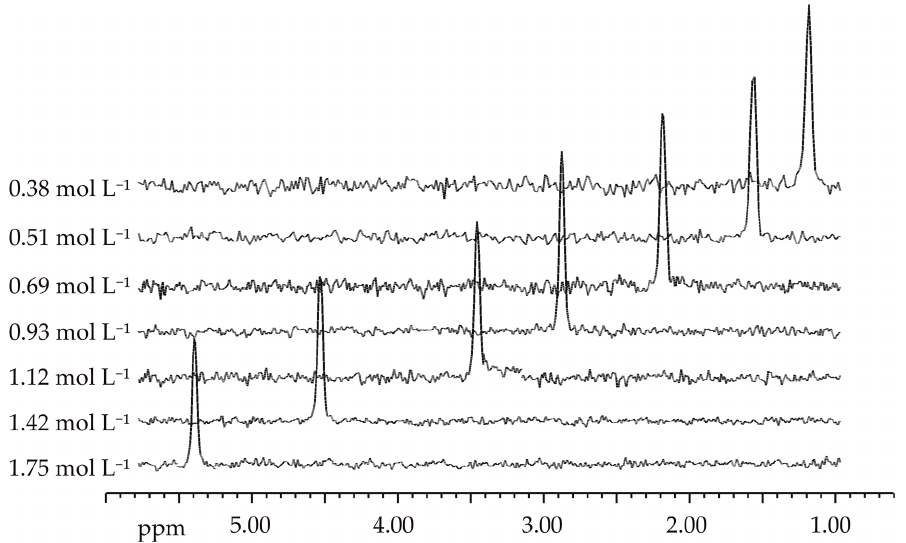
Figure 3. The series of 83 Kr NMR spectra measured at di ff erent krypton densities in the range Figure 3 0.38 ÷ 1.75 mol / L at 300 K. A valuable density shift is clearly visible.